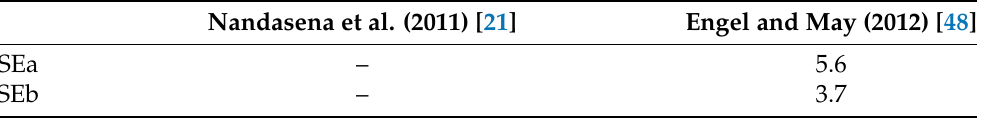
Table A25. Minimum wave heights H m (m) required to displace the boulders of the Torre Sant’Emiliano